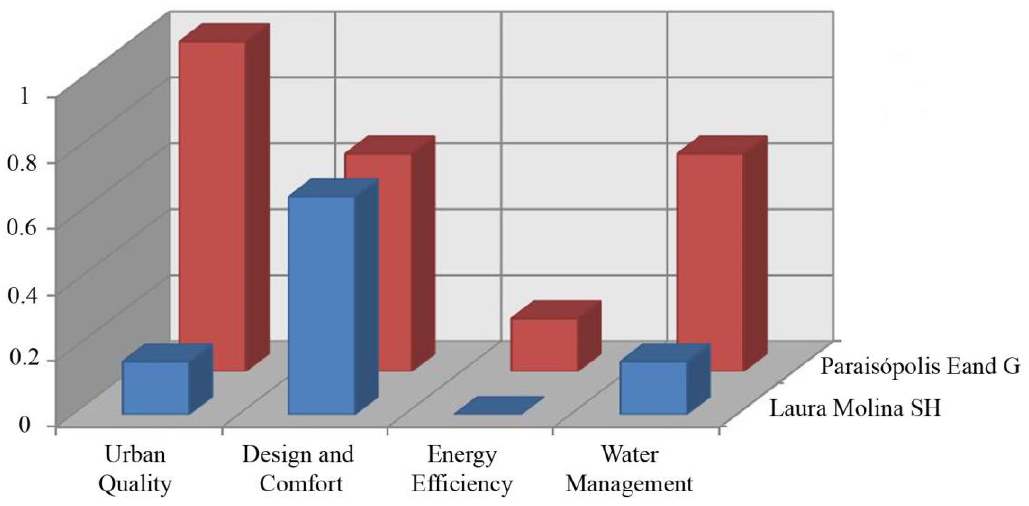
Figure 4. Partial sustainability profile of projects.